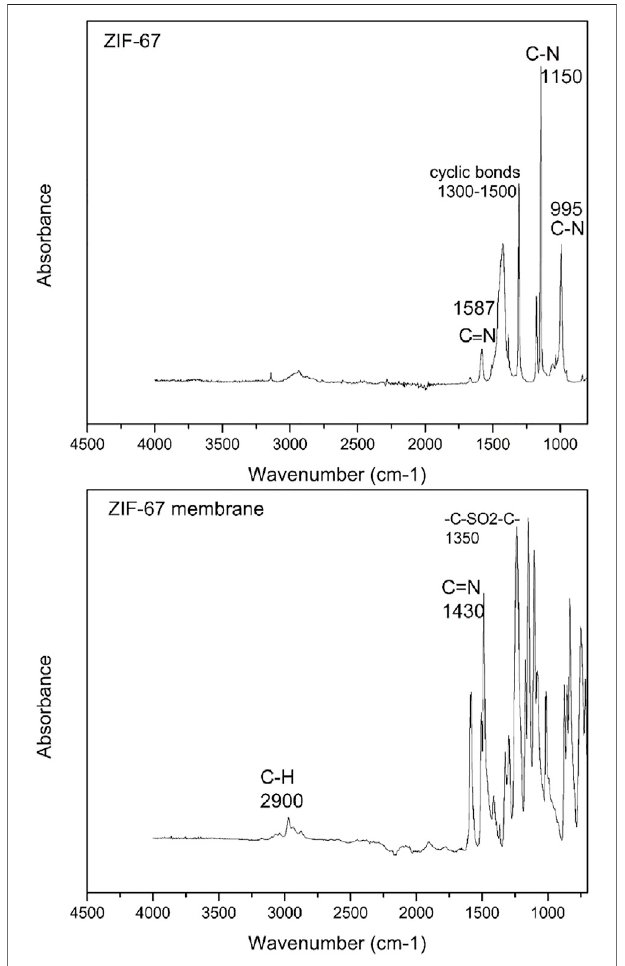
FIGURE 5 | ATR-FT-IR of ZIF-67 and ZIF-67 membrane.